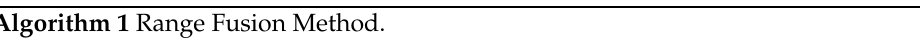
Algorithm 1 Range Fusion